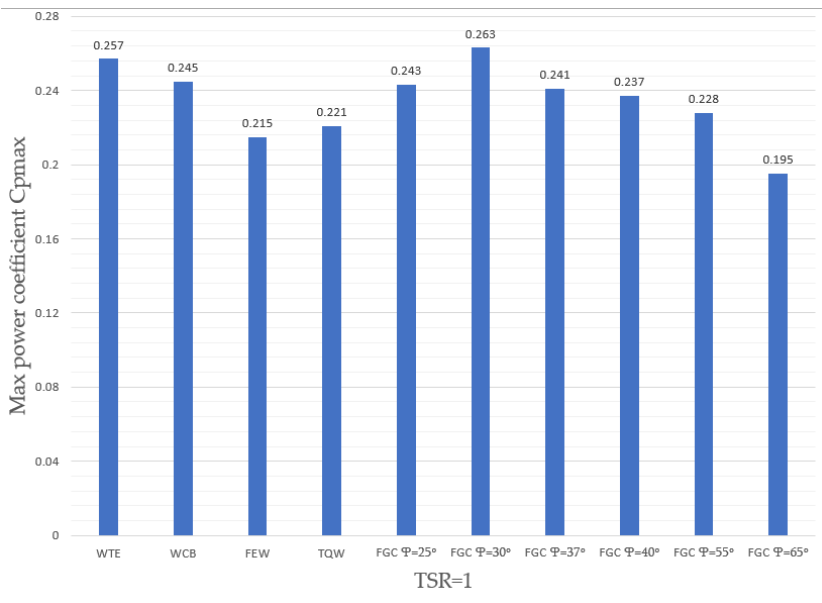
Figure 13. Cp max values obtained from analysis of different blade profiles.